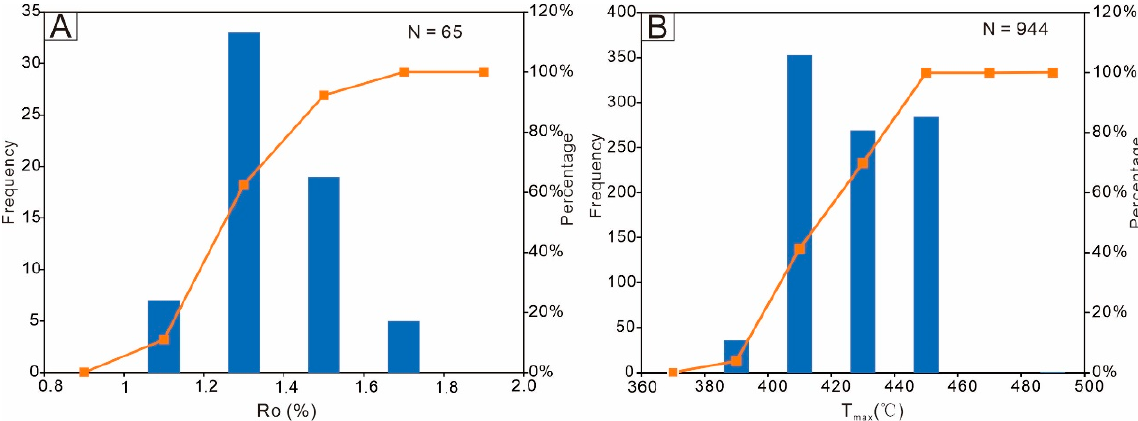
Figure 9. ( A ) Histogram showing the Ro values. ( B ) Histogram showing the T max values.